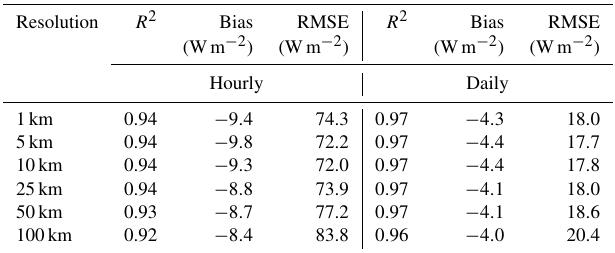
Table 4. Summary of spatial and temporal influence on hourly and daily DSR